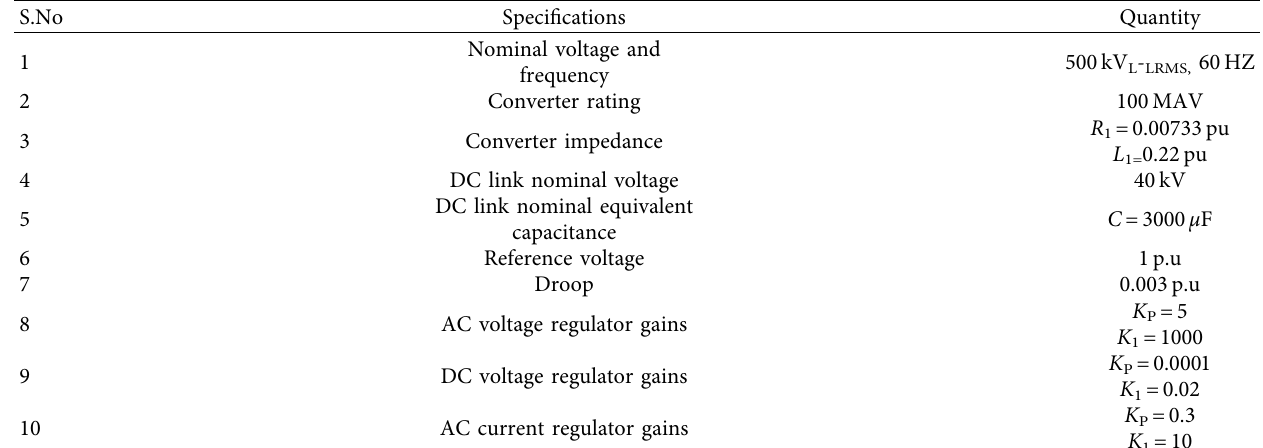
Table 9: Conventional STATCOM parameters [35].